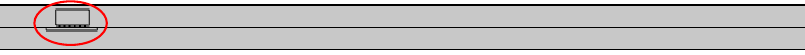
Fig. 2 Finite element simulation model of electromagnetic ultrasonic thin plate testing